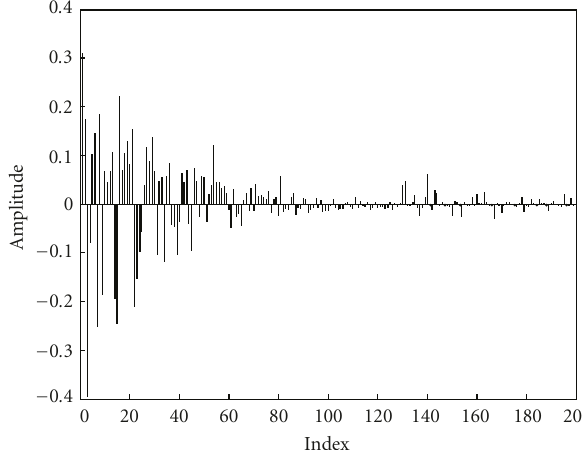
Figure 1: UWB channel impulse response of the light of sight (LOS), 1–4